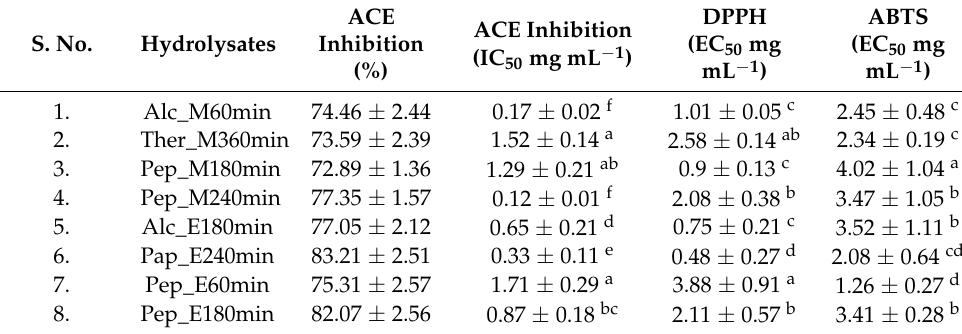
Table 1. ACE inhibition and antioxidant activities of selected